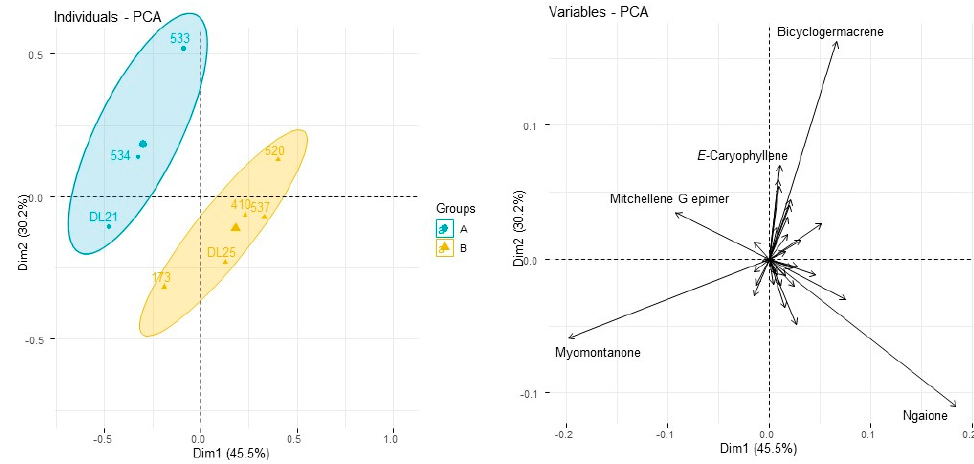
Figure 8. Principal component analysis including loadings plot of essential oil components from Eremophila sturtii